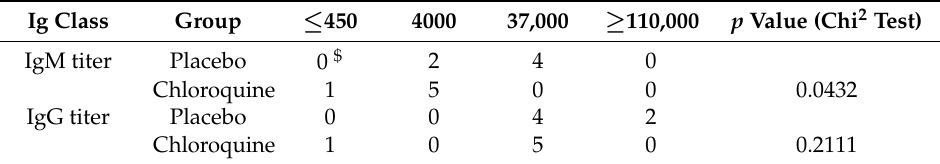
Figure 5. CHIKV-specific cell-mediated immunity is delayed by chloroquine treatment. The cell-mediated anti-CHIKV immune response was assessed by IFN- γ ELISPOT assays on leukocytes that were stimulated with CHIKV antigen in vitro, before treatment and infection ( − 5 p.i.), and on days 15 and 23 p.i. Chloroquine treated (black squares) versus non-treated (open circles). * p < 0.05, M&W test. Table 1. CHIKV-specific antibody titers in infected macaque serum collected 15 days